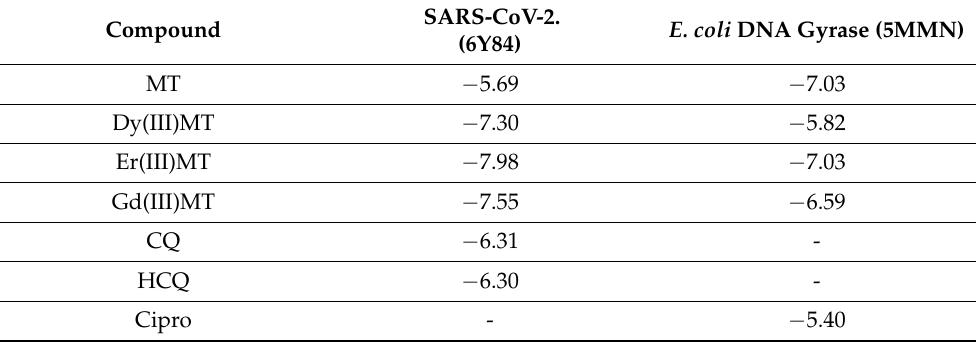
Free binding energy of compounds against SARS-CoV-2 (6Y84) and E. coli DNA Gyrase